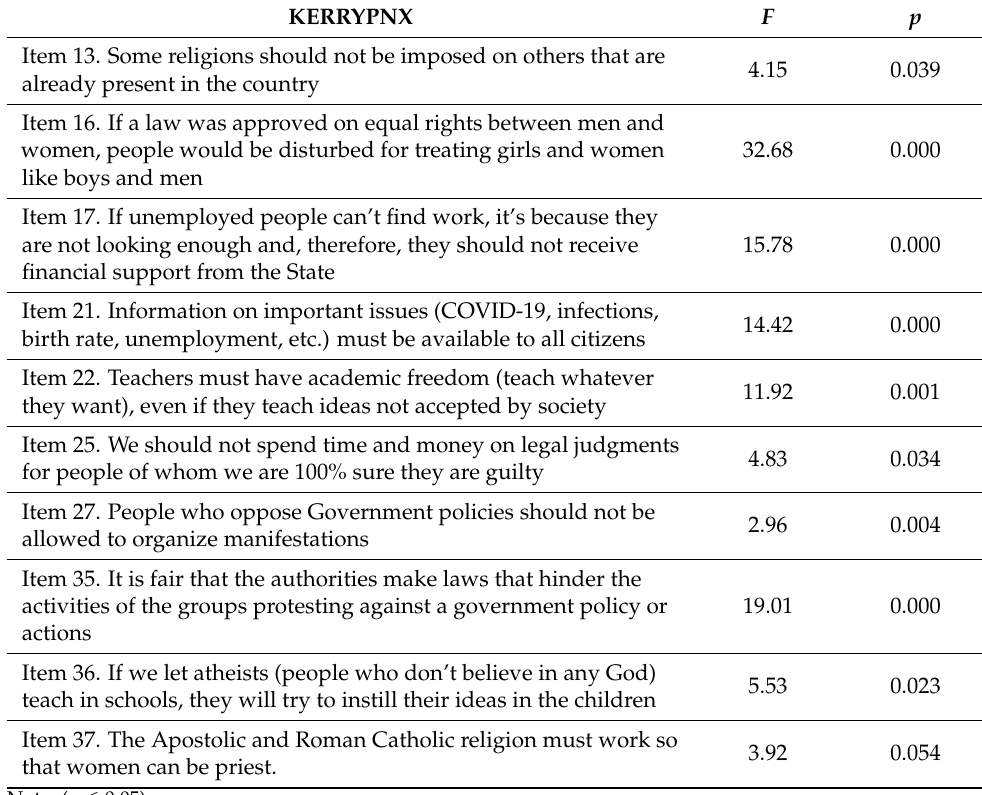
Table 1. Statistically significant intergroup differences in the ATHRI questionnaire. KERRYPNX F p